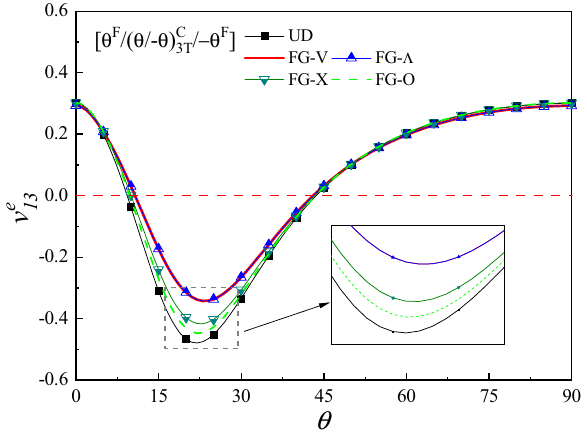
Figure 2: EPR ( v e 13 )- layinganglefor [ θ F / ( θ C / − θ C ) 3T / − θ F ]